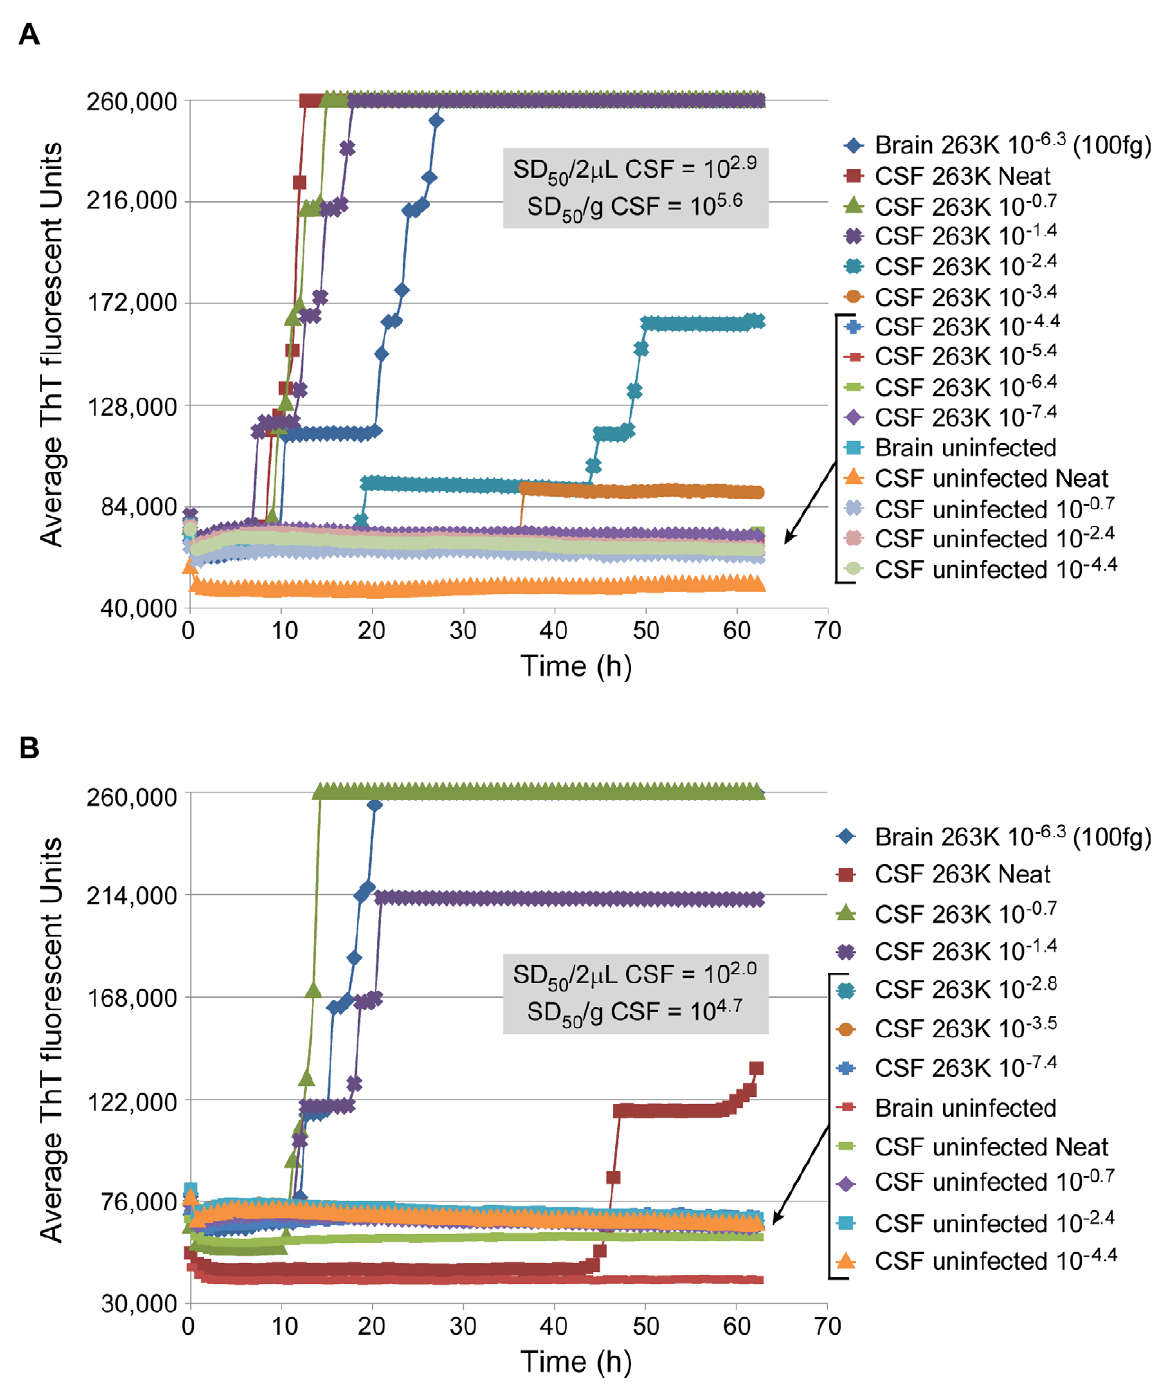
Figure 6. RT-QuIC end-point dilution analysis of CSF from scrapie-infected hamsters. CSF was collected at the clinical stage of disease from two individual hamsters (Panel A and B) i.c.-inoculated with 263K scrapie BH. CSF was serially diluted 5-fold and analyzed by RT-QuIC. Each 0.75 h time point for each dilution is represented as an average ThT fluorescence from 8 replicate wells. The average Spearman-Ka¨rber estimates of the SD 50 /2 m l (the seed volume) and SD 50 /ml neat CSF are shown. doi:10.1371/journal.ppat.1001217.g006 phase on the concentration of seed, as illustrated in Figure 1. The can be established and used to determine relative prion infectivity lag phase might be considered analogous to the TSE incubation levels in unknown samples without resorting to more time- period between the inoculation and the near terminal stage of consuming and animal-intensive end-point dilution analyses. An analogous correlation between prion seed concentration and lag disease. In certain combinations of host and TSE strain, standard curves correlating bioassay incubation period with inoculated dose phase in the seeding assays like the RT-QuIC or ASA might also